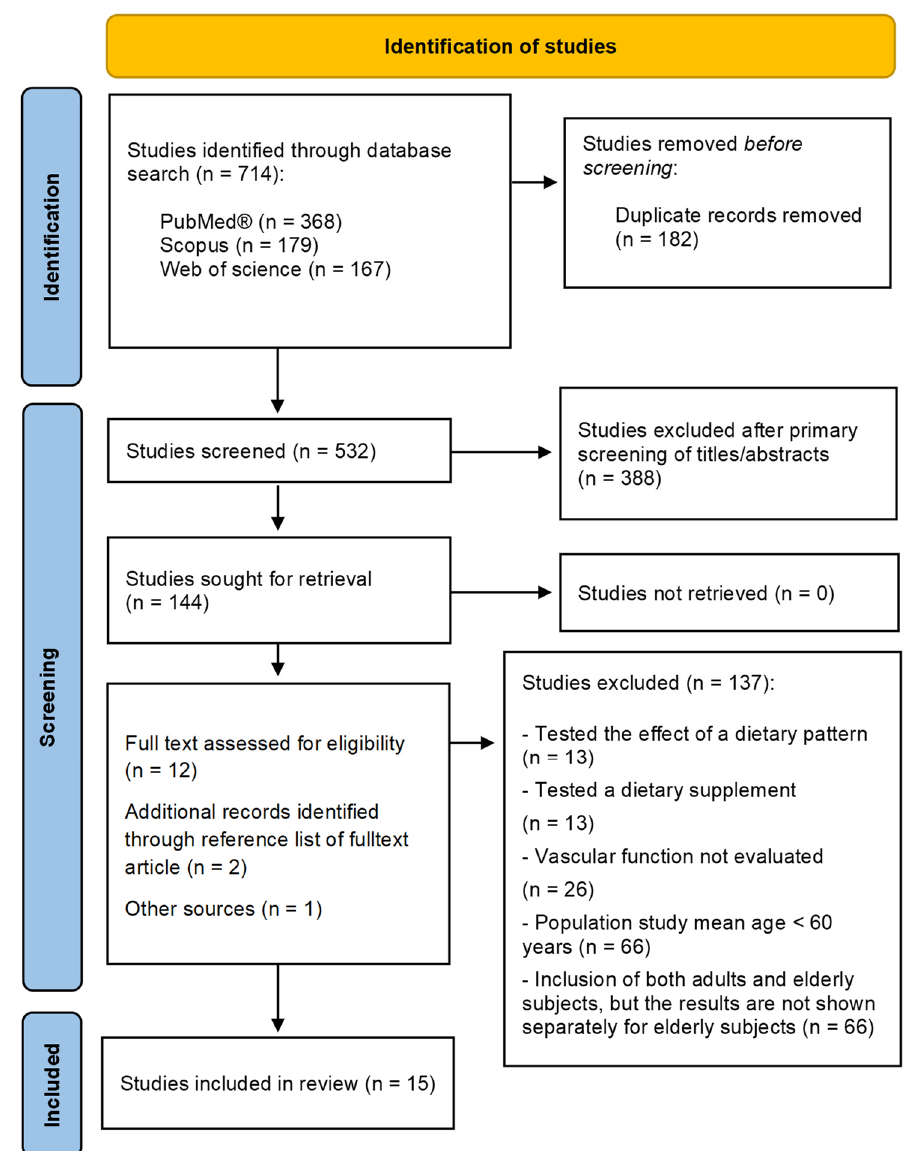
Figure 1. PRISMA flow chart of the systematic review literature search.